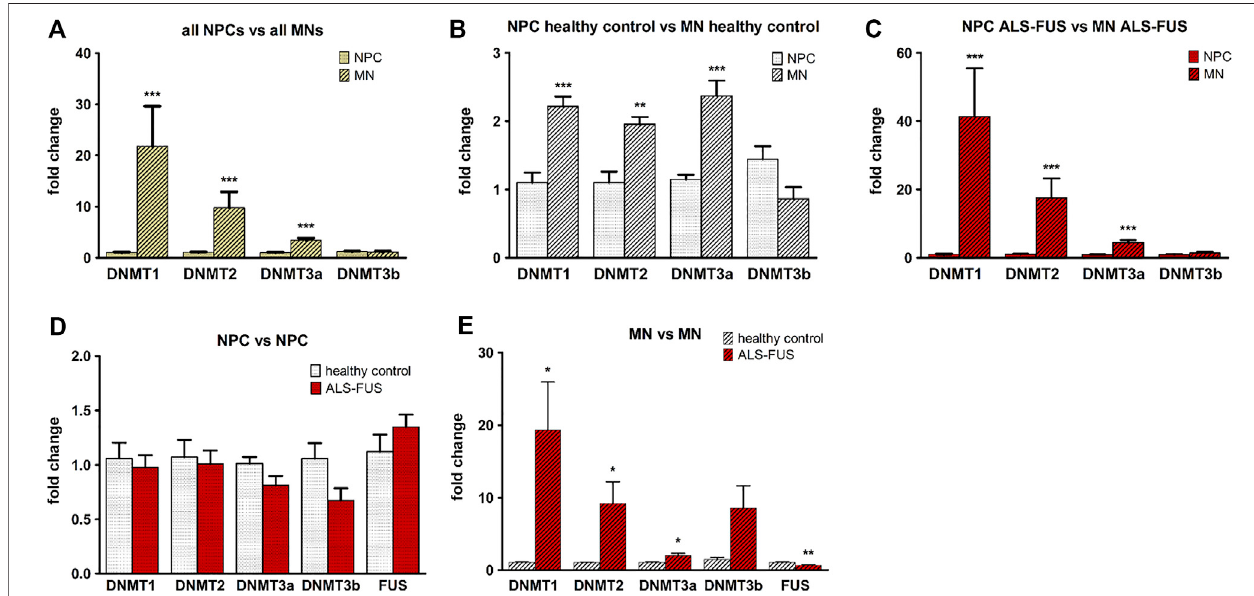
FIGURE 2 | DNMT and FUS expression. DNA methyltransferase (DNMT) upregulation during MN differentiation, (A) Signi fi cantly higher expression of DNMT1, DNMT2 and DNMT3a in all MNs compared to all NPCs, (B) in MNs of control cell lines compared to NPCs and, (C) in MNs of ALS cell lines compared to NPCs. DNMT and FUS expression in controland ALS celllines, (D) NPCs from control and ALScell lines showed nosigni fi cantdifference in expression of DNMT1 , DNMT2 , DNMT3a , DNMT3b and FUS , (E) Motor neurons of ALS cell lines express signi fi cantly more DNMT1/2/3a and less FUS . Graphs show fold change in gene expression normalized to an endogenous reference gene (GAPDH or PPIA) and relative to the calibrator respectively e.g., the healthy control when comparing control and ALS samplesorNPCs whencomparingNPCs withMNs.Statisticalinferences weredrawnfrom unpaired t -test orincaseofnon-normaldistributionfromMann-Whitney test and illustrated as mean ± SEM. Results were regarded as statistically signi fi cant with *** p < 0.001, ** p < 0.01, * p < 0.05, n (cid:2) 3 per condition and n (cid:2) 3 per cell line.